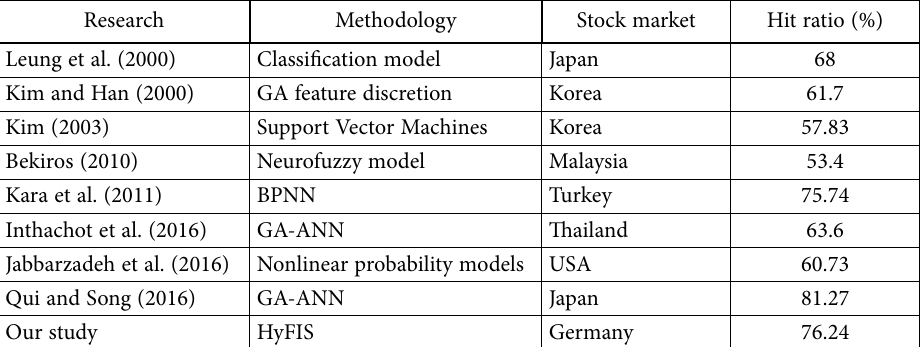
Table 4. Comparison of results with previous studies